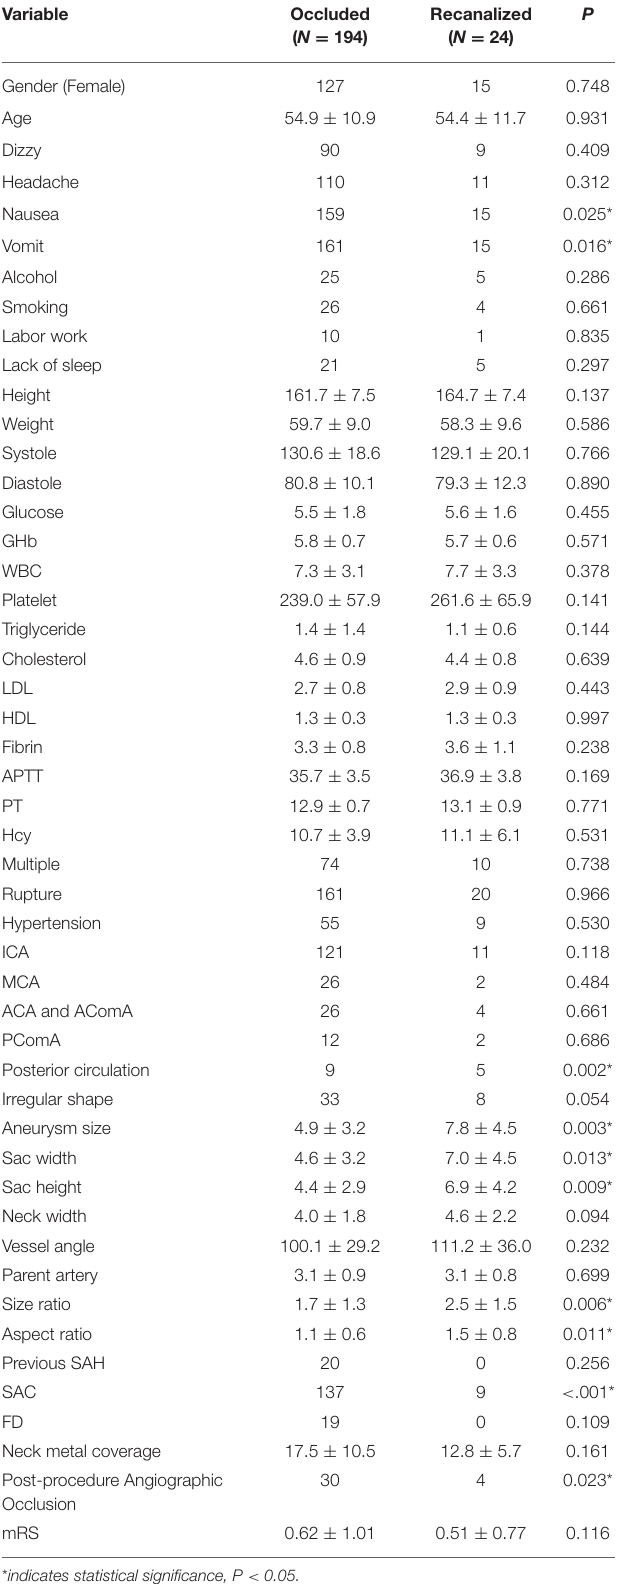
TABLE 1 | Result of univariate